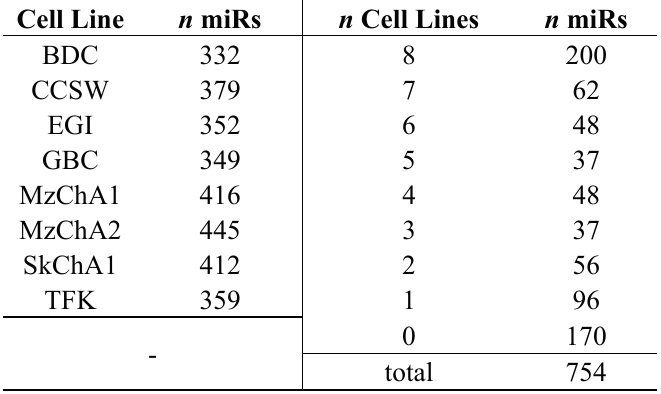
Table 1. MiR-profiling in 8 BTC cell